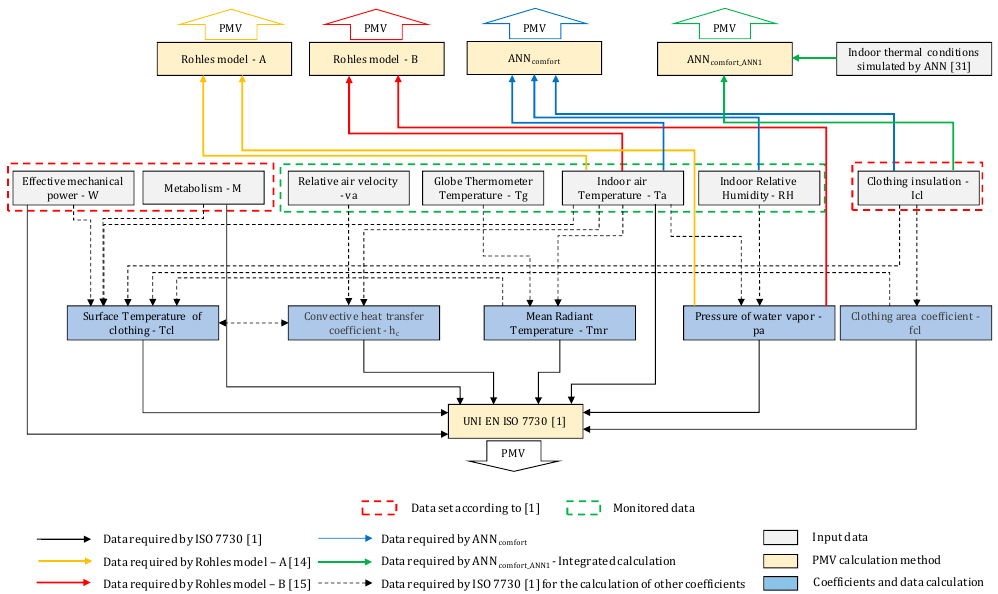
Figure 2. PMV calculation: comparison of the different approaches’ calculation.